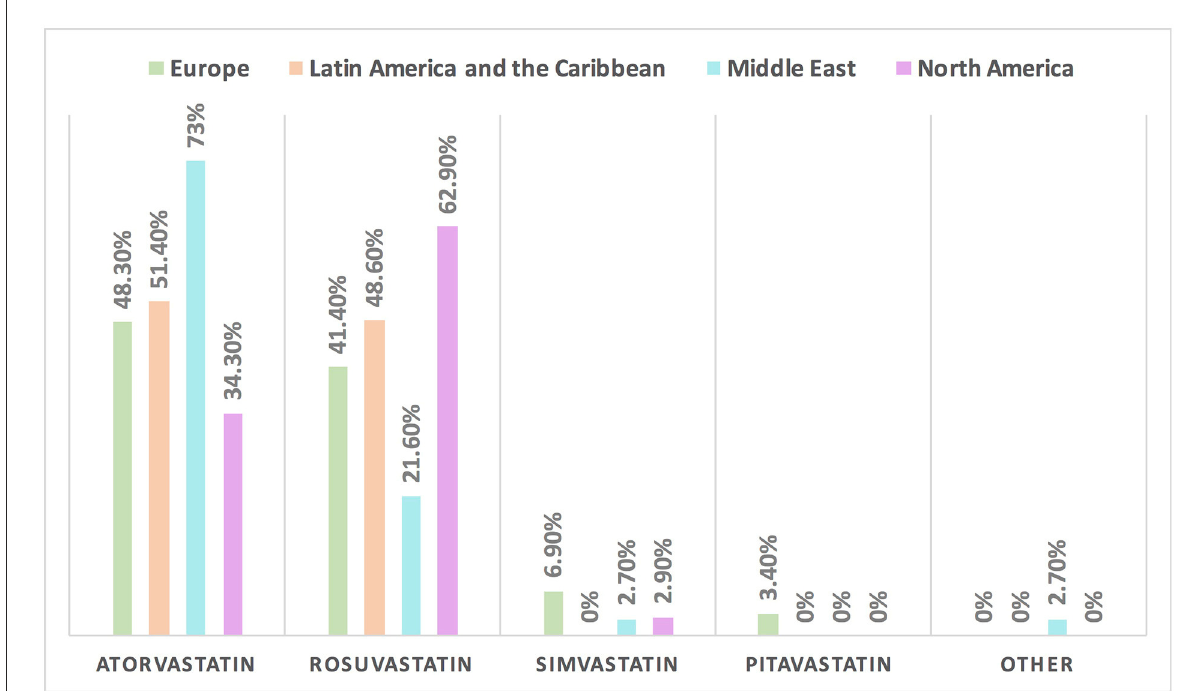
FIGURE6 The most common statin prescribed for patients with cancer in different continents. Atorvastatin is the most commonly prescribed statin among patients with cancer, except in North America where rosuvastatin is the main statin.